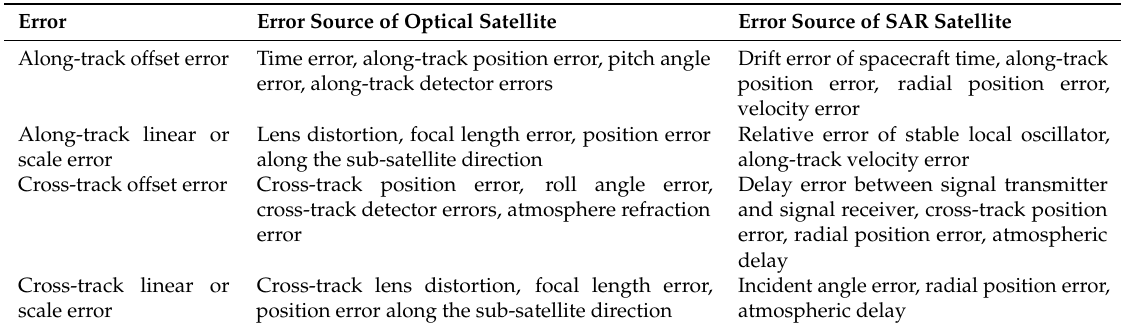
Table 1. Geopositioning error sources of optical satellite and synthetic aperture radar (SAR)